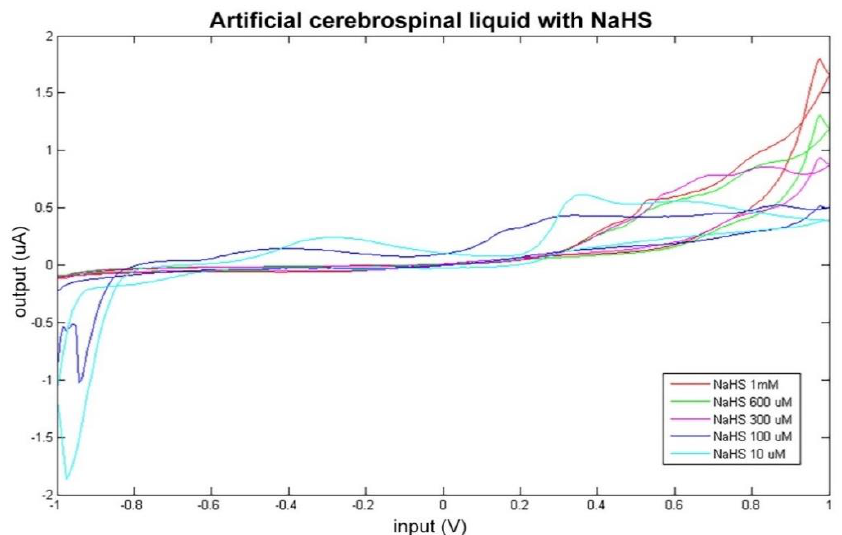
Figure 3. Cyclic voltammetry fingerprint of artificial cerebrospinal liquid with progressive NaHS addition.